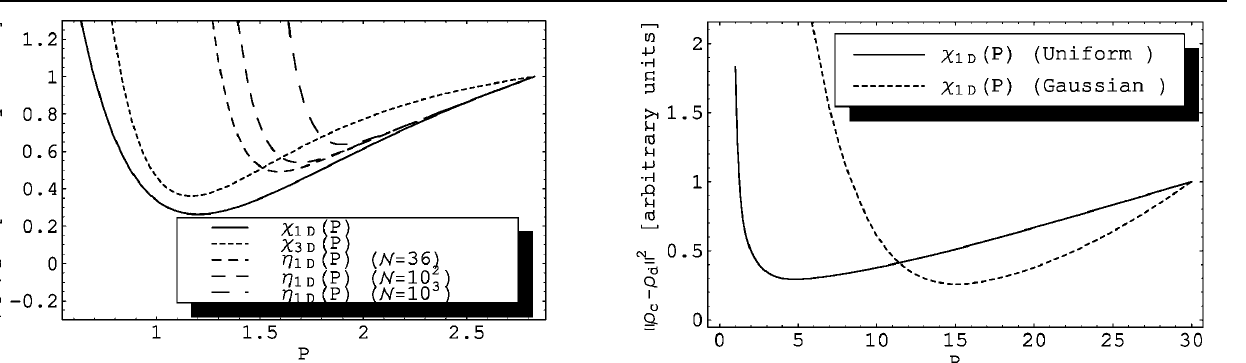
(cid:4) P (cid:5) ( N (cid:6) 36 ) [see Eq. (61)] for a flat and FIG. 6. Plots of / 1D a Gaussian distribution [Eqs. (64) and (68) , respectively]. Macroparticles have been centered at random positions sampled accordingly. The functions have been rescaled as in Fig. 4. The minima occur at much higher values of P than for a flat or Gaussian distributions with equispaced macroparticles (see Figs. 4 and